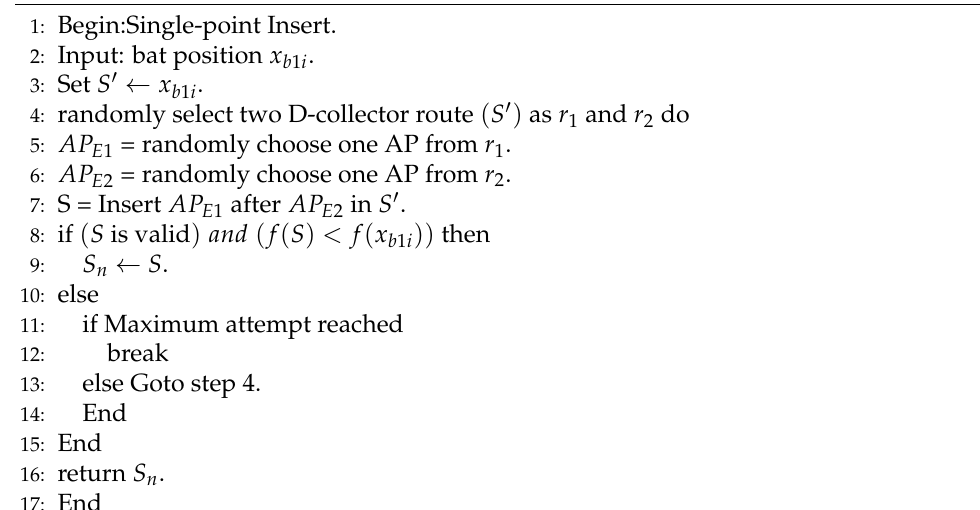
Algorithm 6 Single point insertion